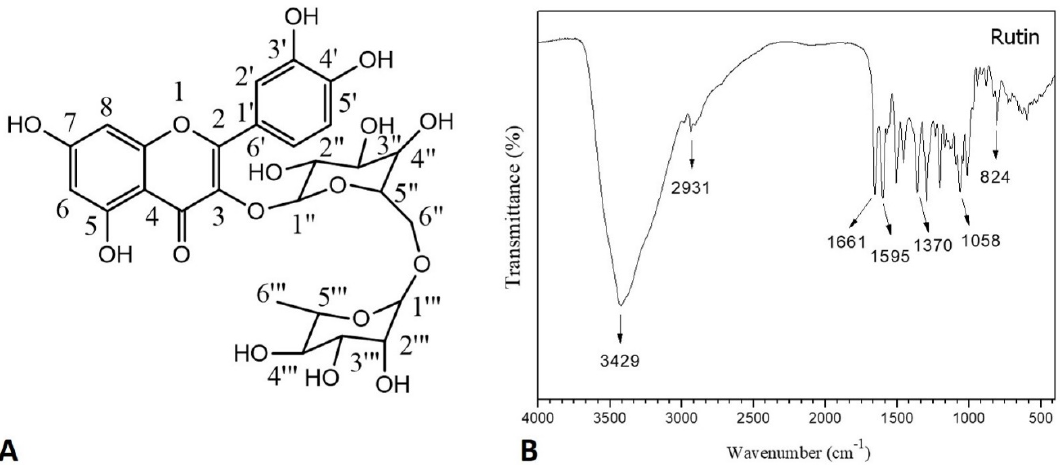
Figure 1. Characterization of Rutin (RUT). ( A ) Chemical structure of RUT; ( B ) Absorption spectroscopy in the infrared region of RUT.